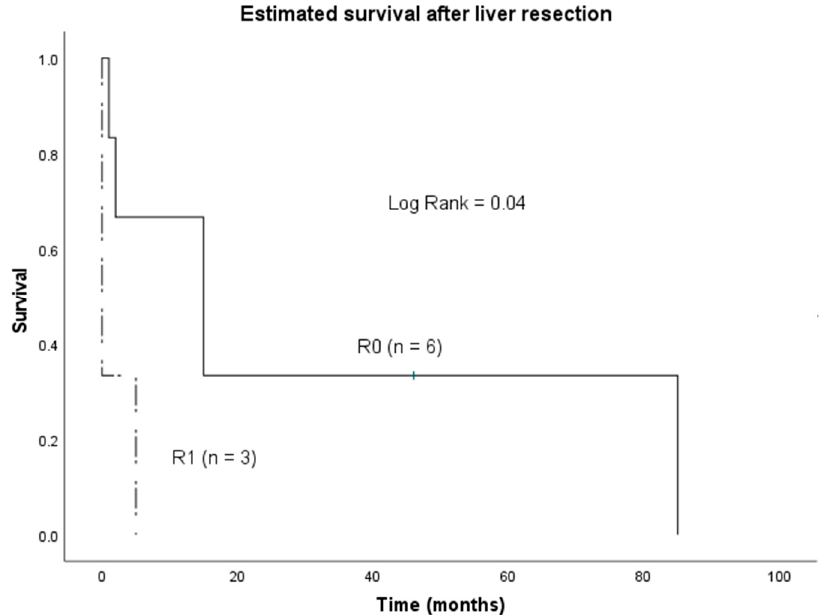
Figure 2. Overall survival of patients undergoing hepatectomy for PHA according to R status R0 vs. R1).